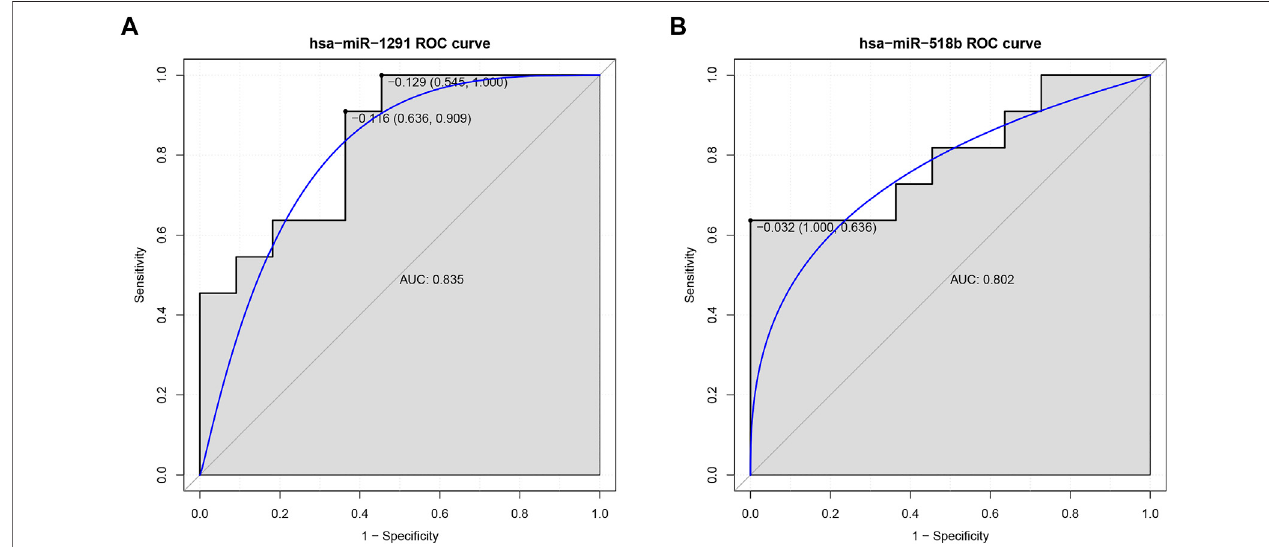
FIGURE6| ROCanalysisofup-regulatedDEMisinIDD. (A) ROCanalysisofmiR-1291; (B) ROCanalysisofmiR-518b.DEMis:differentiallyexpressedmicroRNAs; IDD: intervertebral disc degeneration; and ROC: receiver operating characteristic.